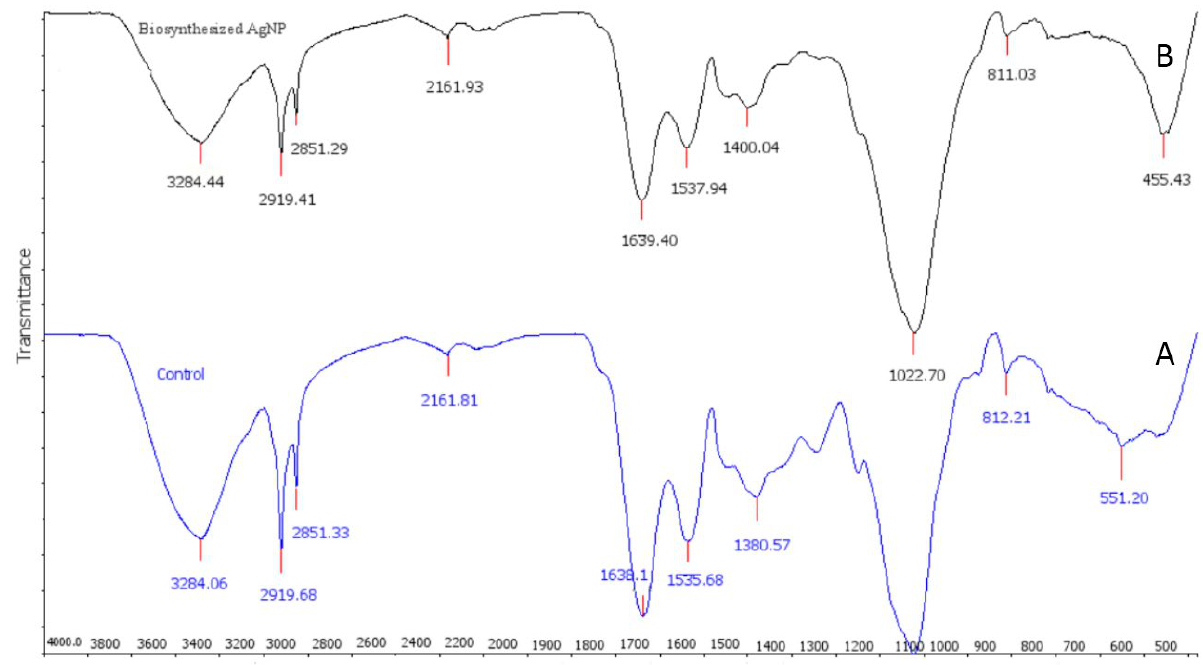
Fig. 5. FT-IR spectrum for A. Desmodesmus sp. control group; B. Desmodesmus sp. formed LAC-AgNPs.